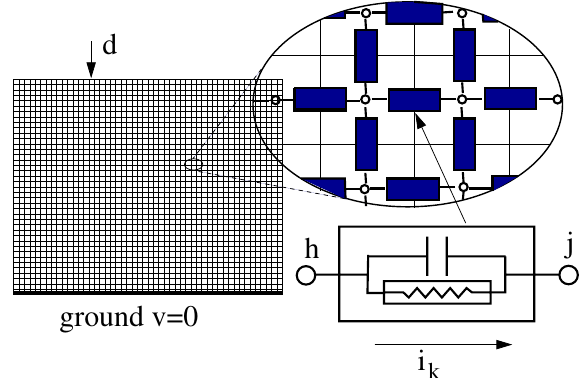
Figure 1. Electrical grid model. The electrical grid model with capacitances and possibly nonlinear resistors connecting adjacent terminals. In the graph representation, each terminal is associated with a node and each electric component with a